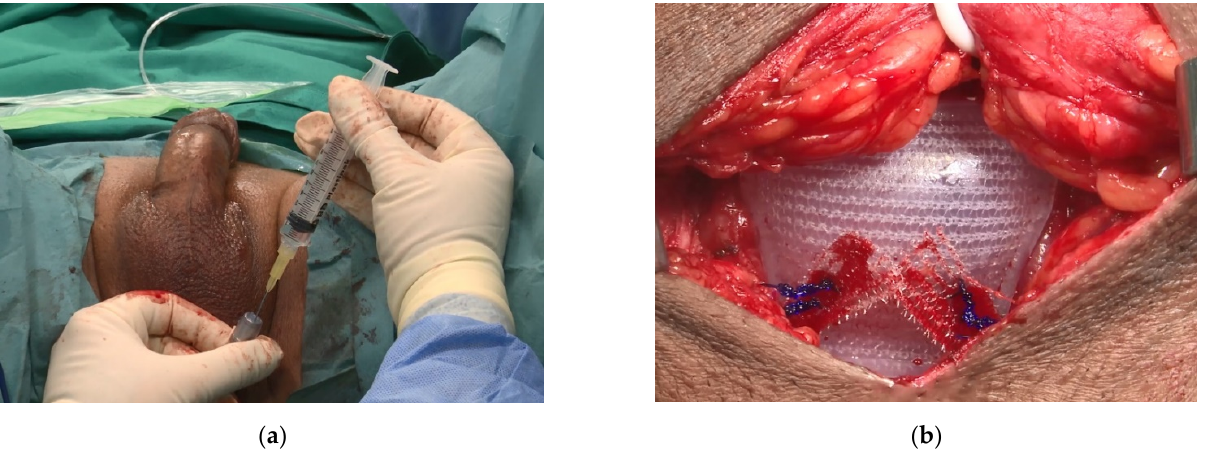
Figure 1. Operative view at the time of the ATOMS implant with a T-DOC air charged urethral catheter to perform intraoperative urodynamics. ( a ) Controlled system filling of the port through a perineal incision; ( b ) the ATOMS cushion inflated with variable volumes caused a change in intraurethral pressures that were registered by urodynamic equipment.